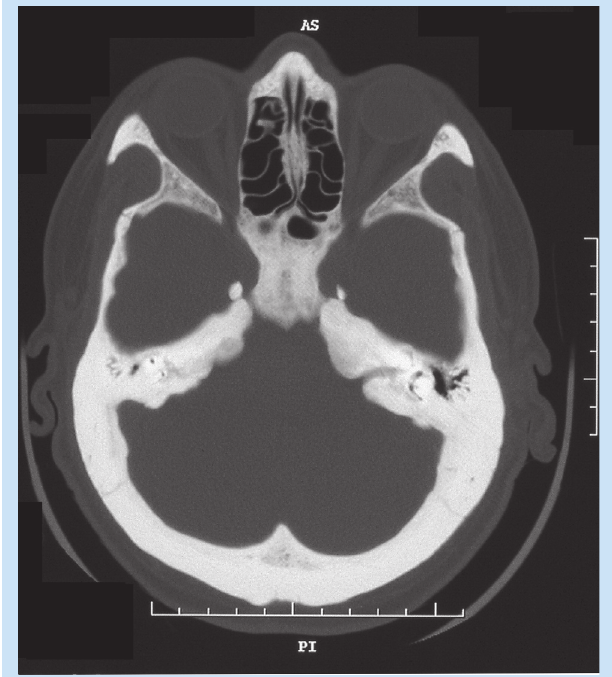
Fig. 1. Axial CT scan showing generalised thickening of the cranial vault.